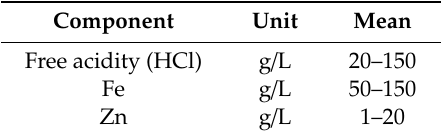
Table 1. Acid and metals concentration ranges of a pickling solution (data provided from Tecnozinco SrL, Carini,